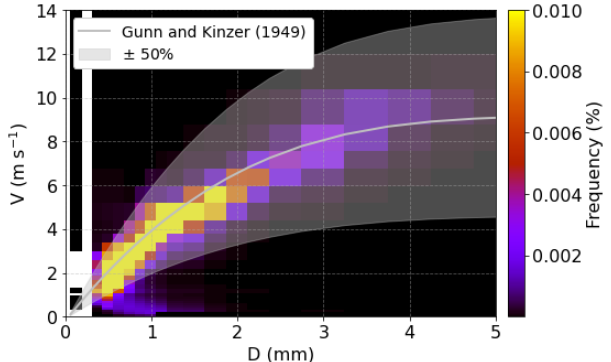
Figure 2. Normalized histogram of measured fall speed vs. drop size for the entire 13-disdrometer dataset before quality control. Zero values are masked (white). The gray curve represents the expected terminal velocity given by Equation (1), and the shaded area indicates the ±50% thresholds. Although the maximum frequencies fell mostly inside the shaded area, the unfiltered sample presented above-zero frequencies for almost all sizes and speeds in the spectrum (zero values were masked), which proved the importance of this step. The largest